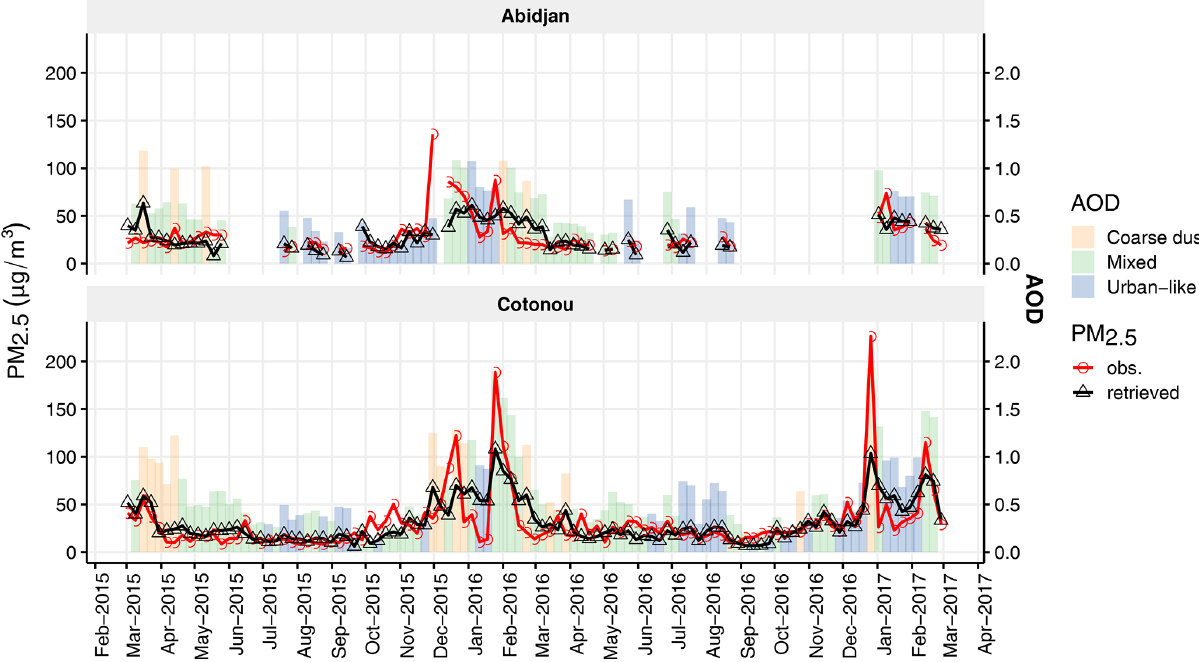
Figure 9. In situ and AOD-derived mean weekly PM 2 . 5 from March 2015 to March 2017 in Abidjan and Cotonou. Vertical color bars give the weekly AOD by aerosol